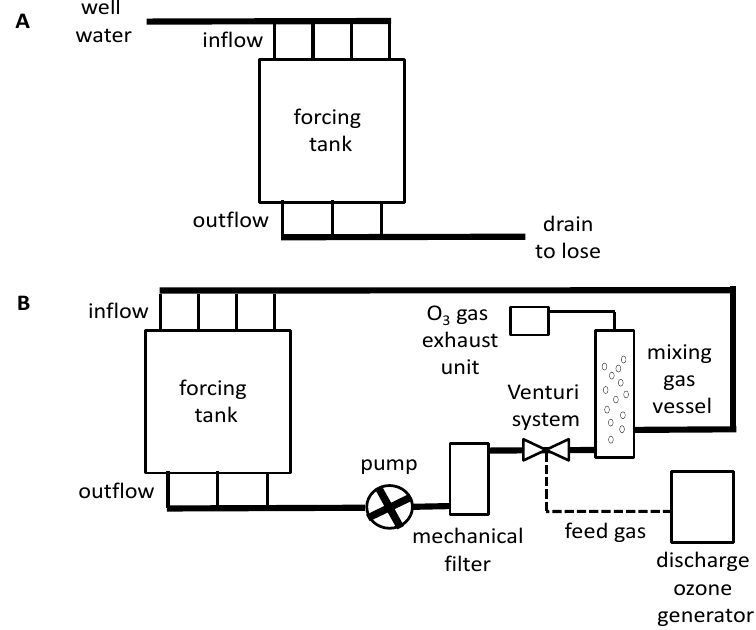
Figure 3. Schematic diagram of the traditional forcing-process system ( A ) and the closed loop forcing system with ozone water treatment ( B ).